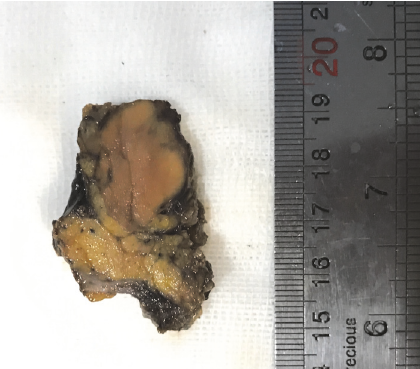
Figure 3: Gross appearance of mass. There is a well-defined tan-brown mass with solid cut surface attached to normal parotid tissue.